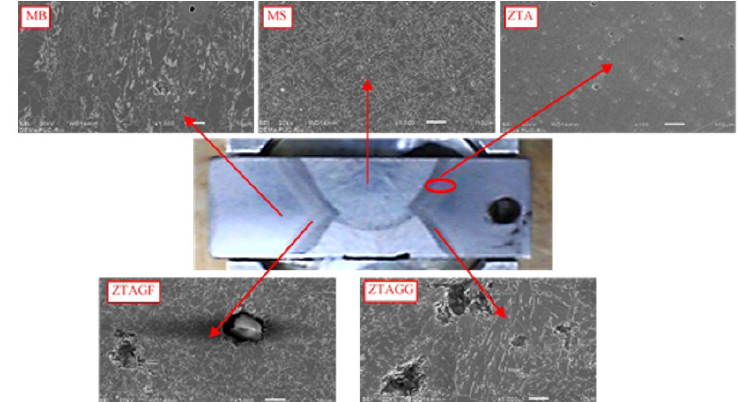
S O ) (pH=3.0). 2 2 3